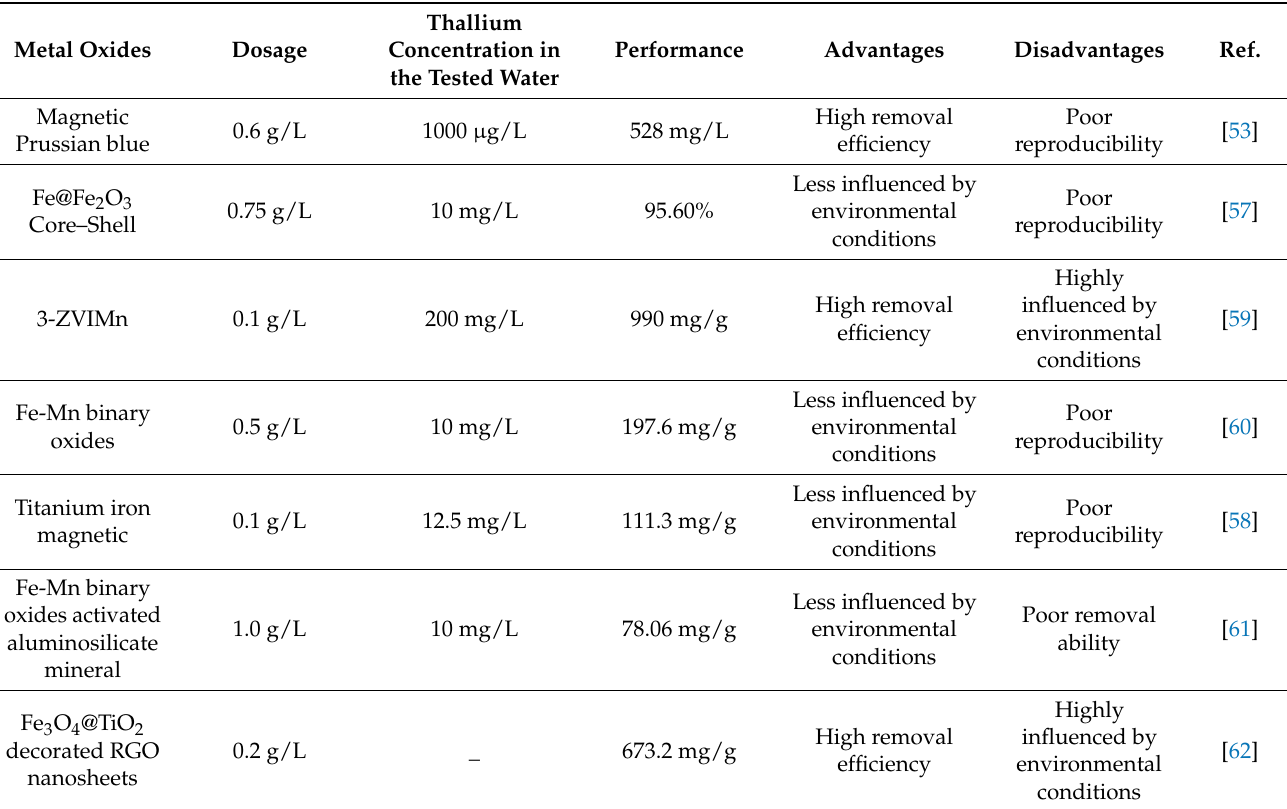
Table 2. Iron oxide removal thallium performance and its advantages and disadvantages.